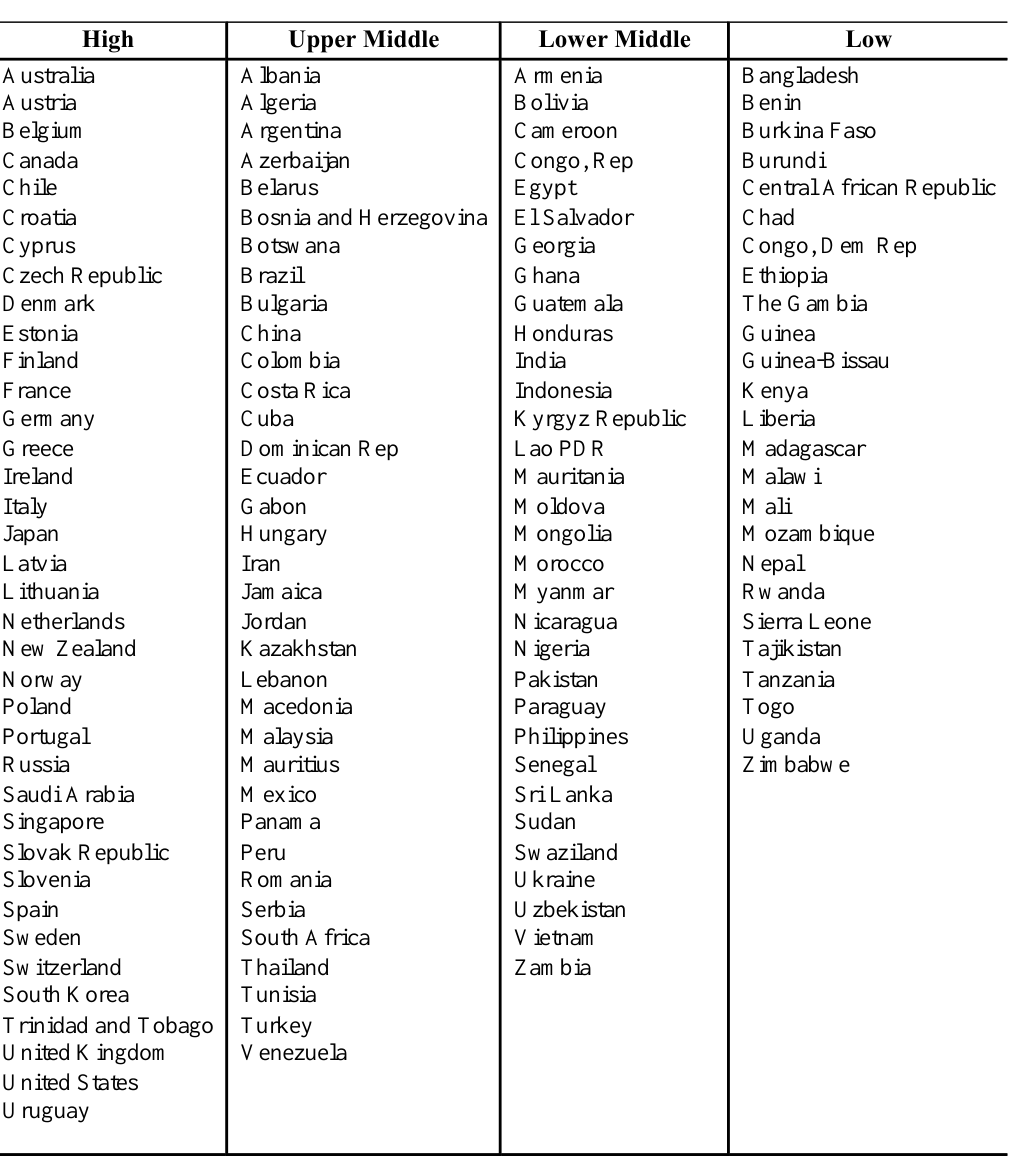
Table 1. Countries included in the Study by Income